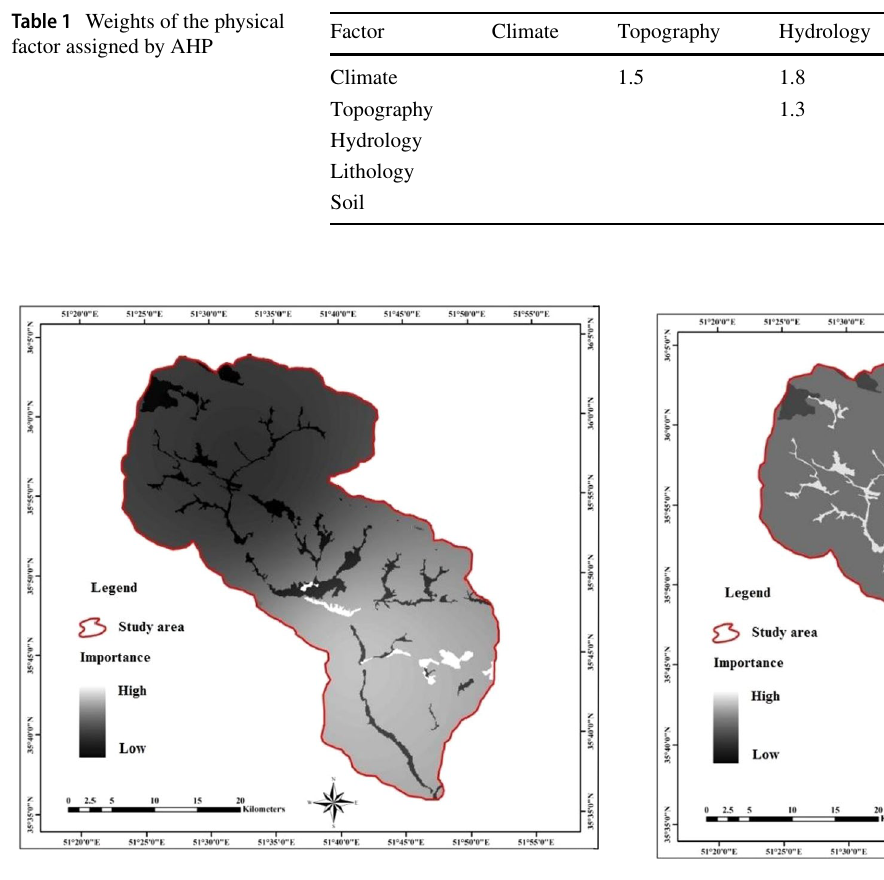
Fig. 1 Eco-hydrologic stability map of the biological factor